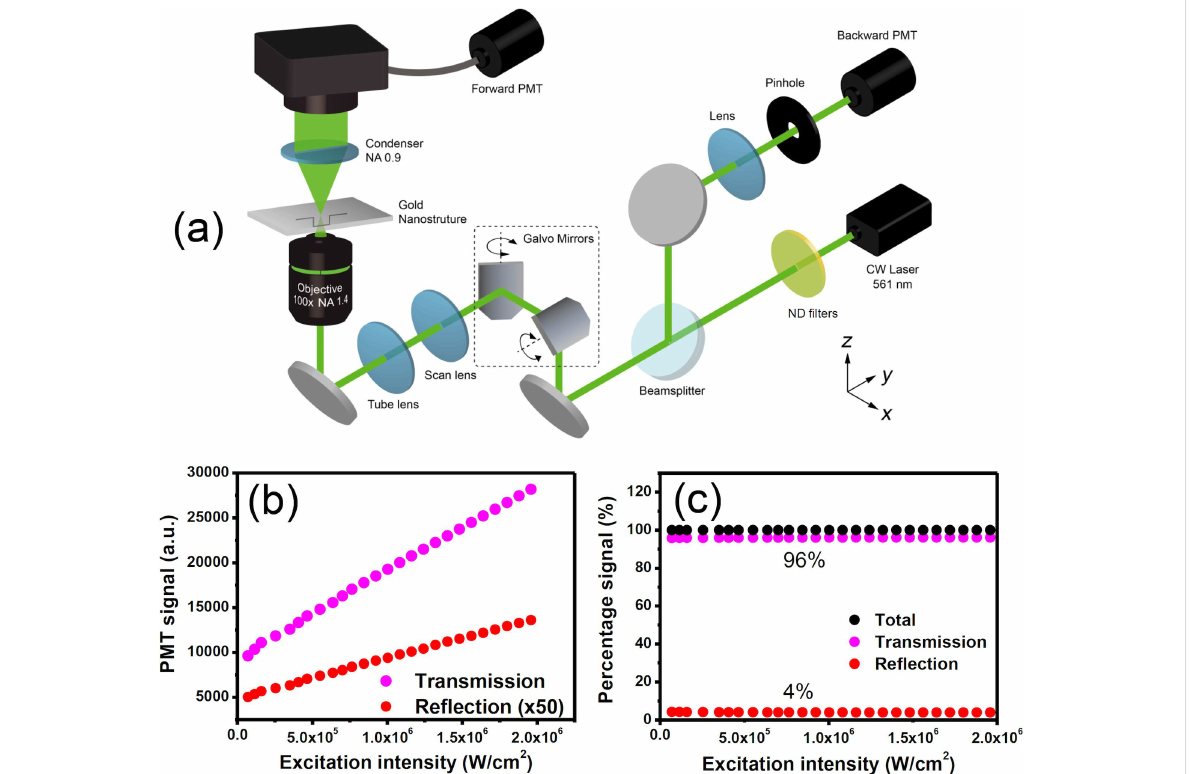
Figure 6: (a) Schematic of the experimental setup of the laser scanning system based on an inverted microscope. (b) Linearity test of the backward and forward signals from the partial reflection and transmission of a cover glass. It is obvious that no nonlinearity is induced by the microscope system. (c) The forward and backward signals are calibrated to correctly represent 4% reflection and 96% transmission from an air–glass interface. The same calibration applies to all signal processing in the main